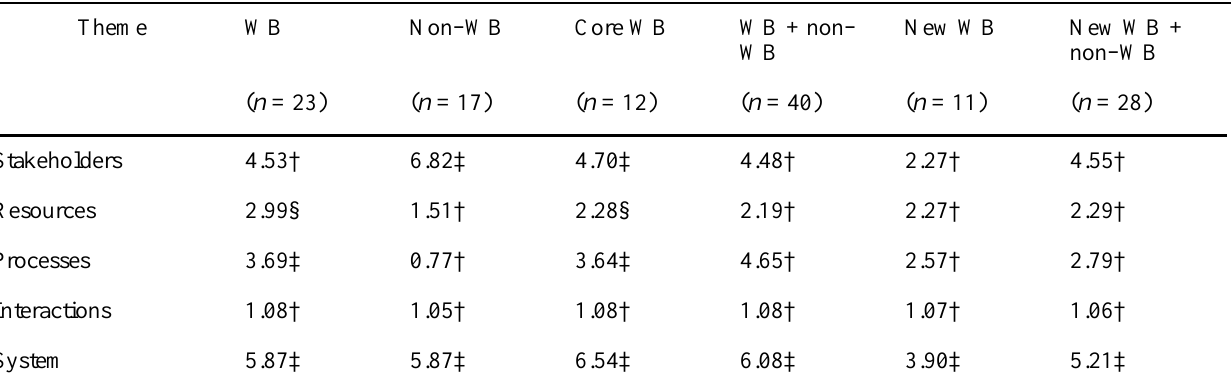
Table 2 . Summary results of the consensus analysis for each sample and subsample. Data are the eigenratios. A value > 3 indicates that there is consensus between elements of the mental model assuming no negative competence scores. Where the latter existed, the evidence did not support a consensus model. For the "system" analysis, all stakeholder, resources, and processes were included but the interactions data were excluded. WB, Water